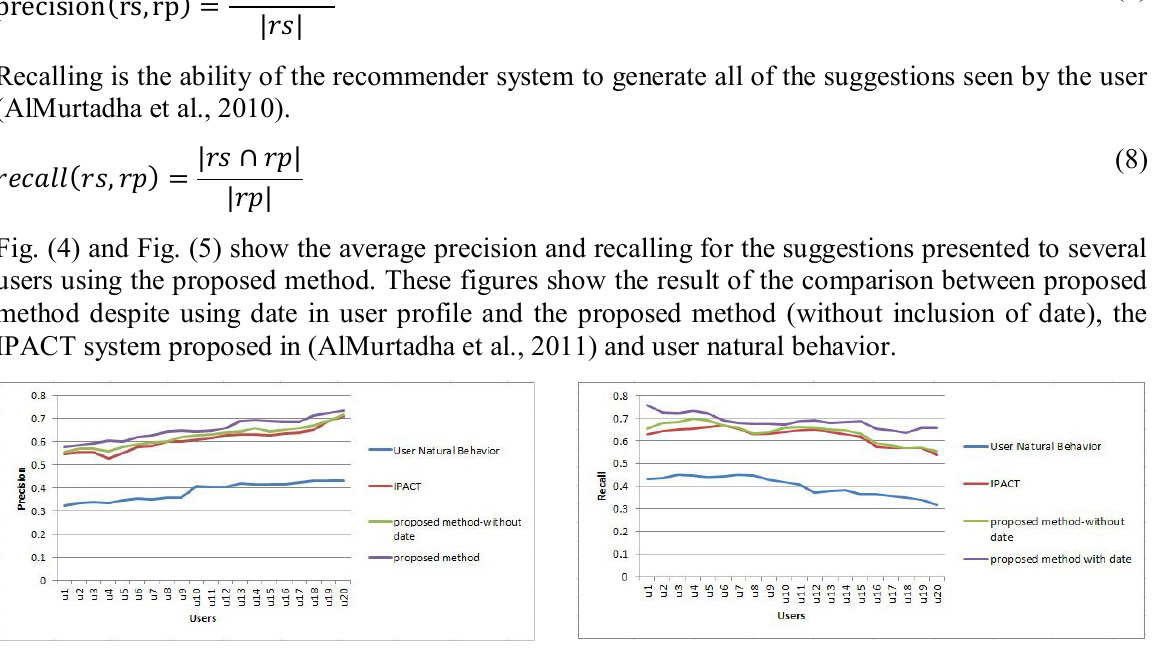
Fig. 4. Comparison Chart of the number of users using the precision criterion